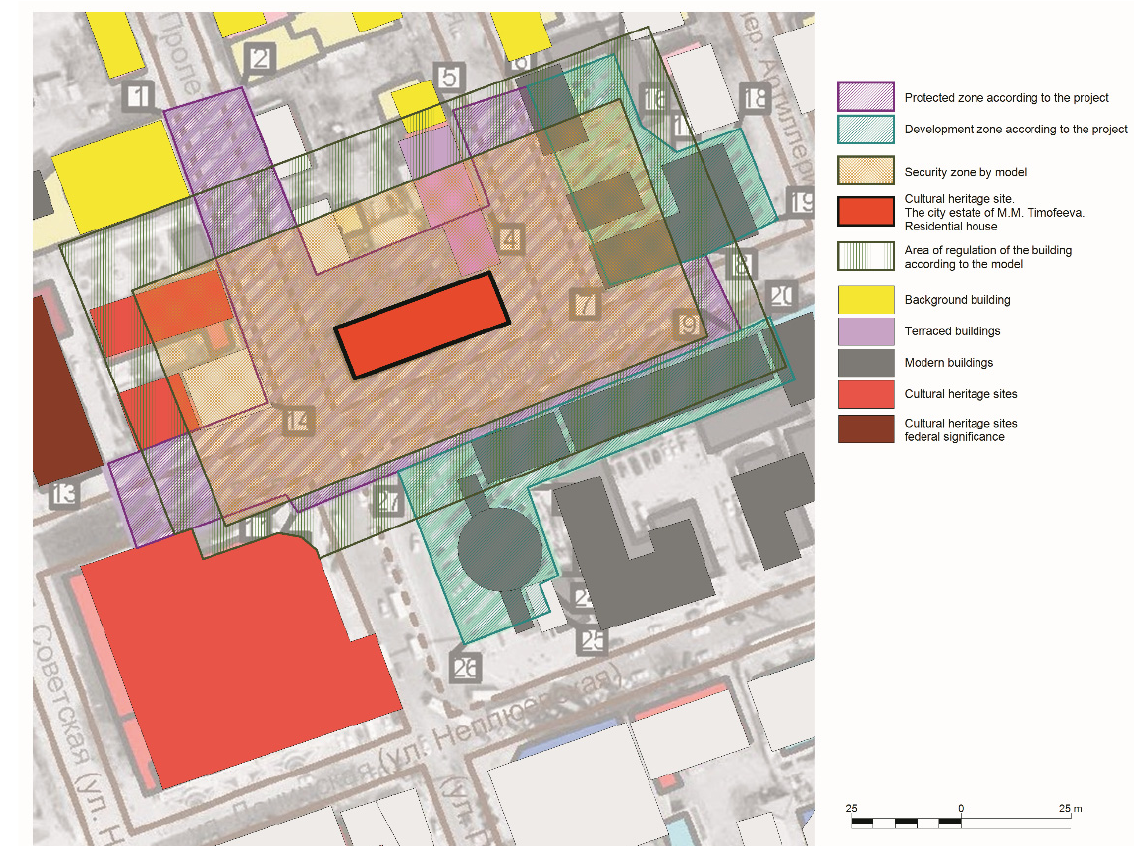
Figure 9. Designing the boundary of protection zones of the cultural heritage site “City estate of M.M. Timofeev Residential House,” located at 24 Pushkin str., Orenburg.